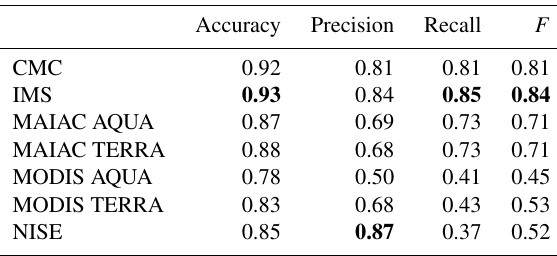
Table A3. Evaluation of daily snow extent data set performance for 2015. GHCN-D surface observations are used as “truth”. All products are regridded to a common 25km resolution. The highest value for each metric is shown in